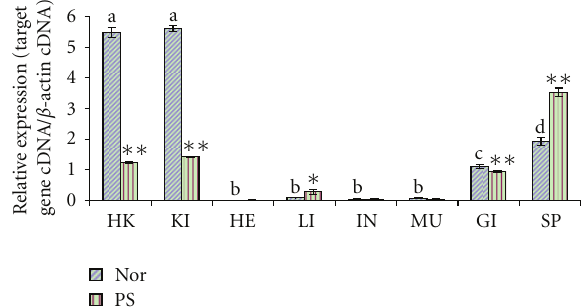
Figure 3: Quantitative analyses of the expression profiles CXCR4 gene in di ff erent tissues: head kidney (HK), kidney (KI), heart (HE), liver (LI), intestine (IN), muscle (MU), gill (GI) and, spleen (SP). Tissues were harvested from the PS-injected (PS) and noninjected (Nor) turbot. The expression level was analyzed by one-way ANOVA followed by Duncan’s test. Groups marked with the same letters are not statistically di ff erent. ∗ p < . 05; ∗∗ p < . 001 as compared to the